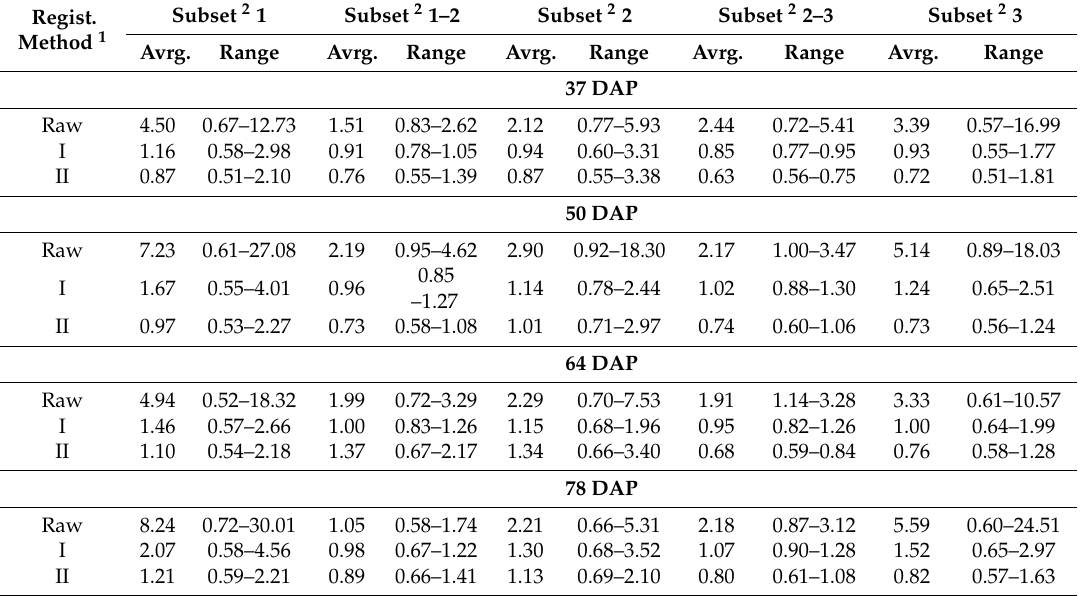
Table A1. Band-to-band registration accuracy (RMSE in pixels) within and between spectral band subsets for ground-based images. Results are summarized for each acquisition date indicating average (Avrg.) and range of RMSE values observed for the images acquired in a given date ( n = 8 sampling